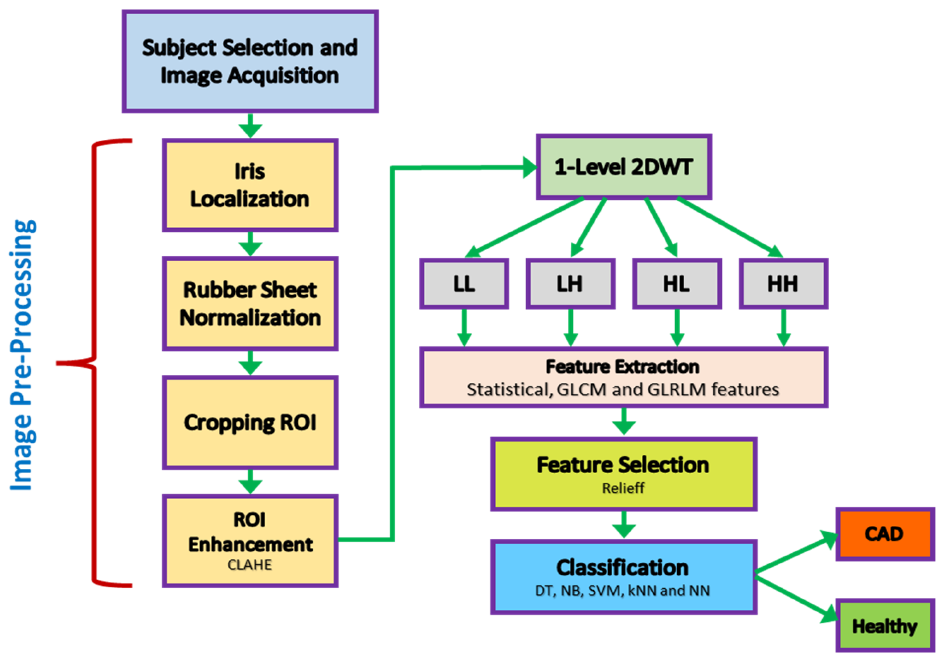
Figure 1. Proposed methodology.